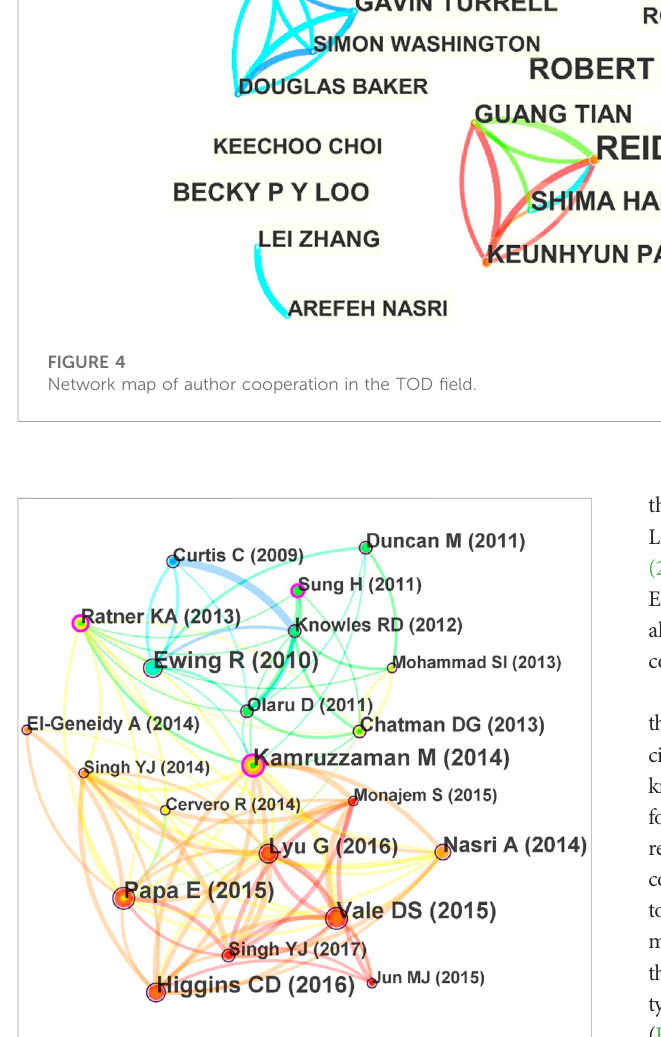
FIGURE 5 Network map of document co-citation on TOD